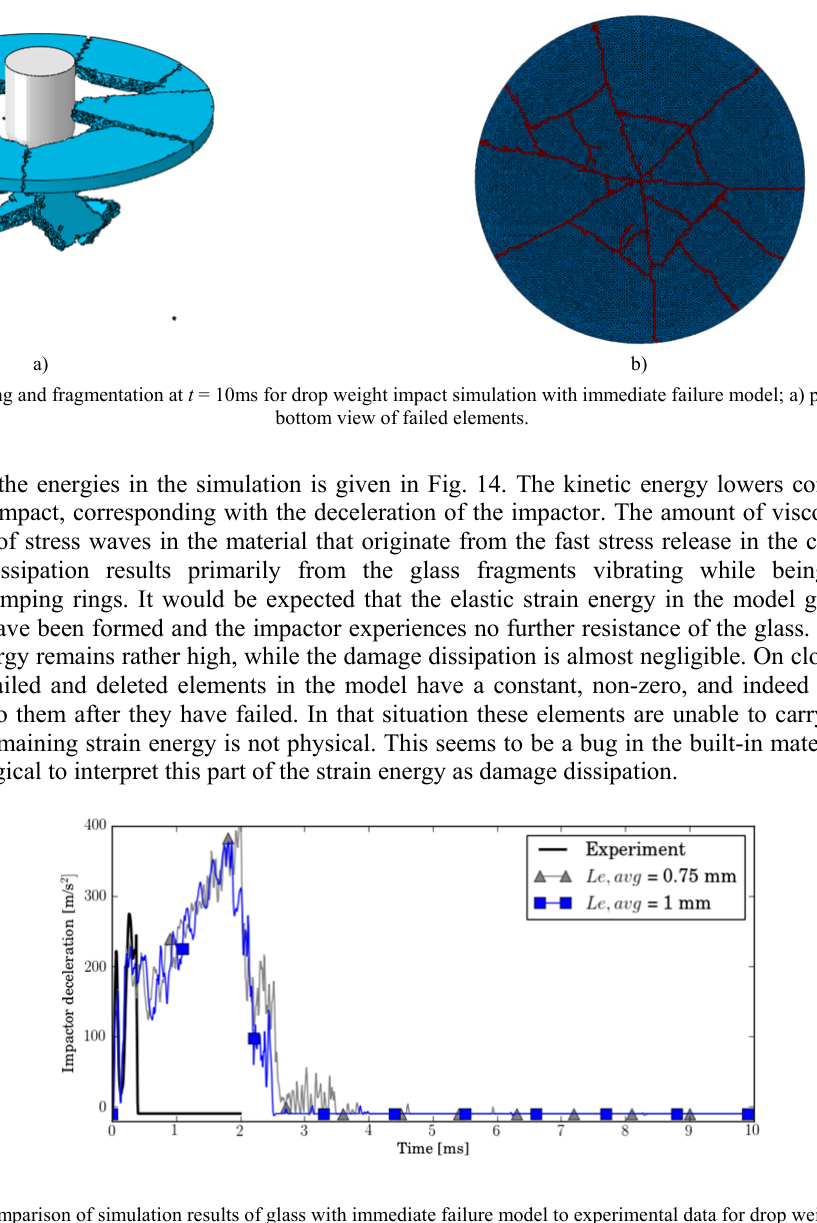
Fig. 13 Comparison of simulation results of glass with immediate failure model to experimental data for drop weight impact.